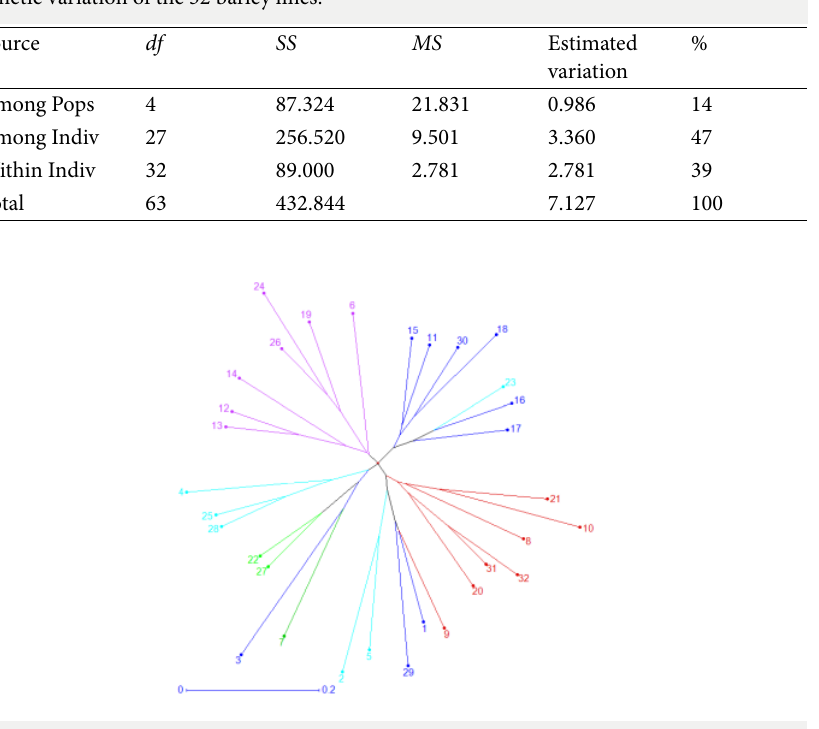
Figure 2 Unweighted neighbor-joining dendrogram showing genetic relationship among the 32 barley accessions based on the genetic dissimilarity matrix data of SSR markers alleles. All the accessions were divided into four groups. The colors of branches indicate accessions corresponding to the clusters (Cluster 1 to 5) from population structure analysis as in Figure 1. Numbers indicate accessions mentioned in Table